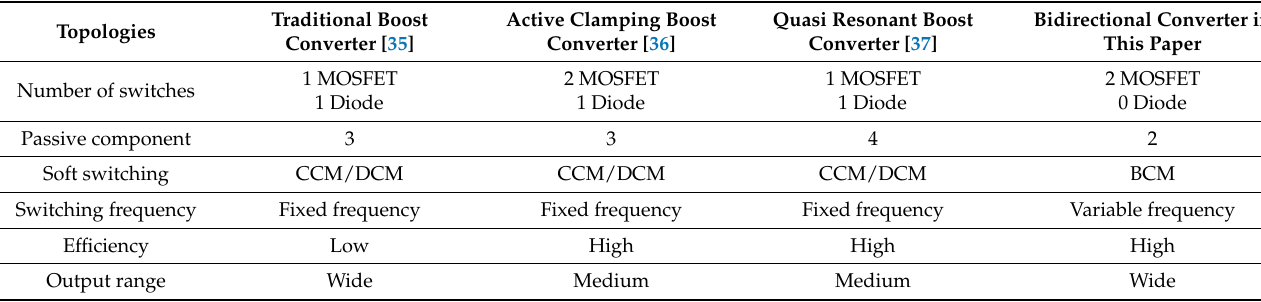
Table 3. The comparison of BCM controls.